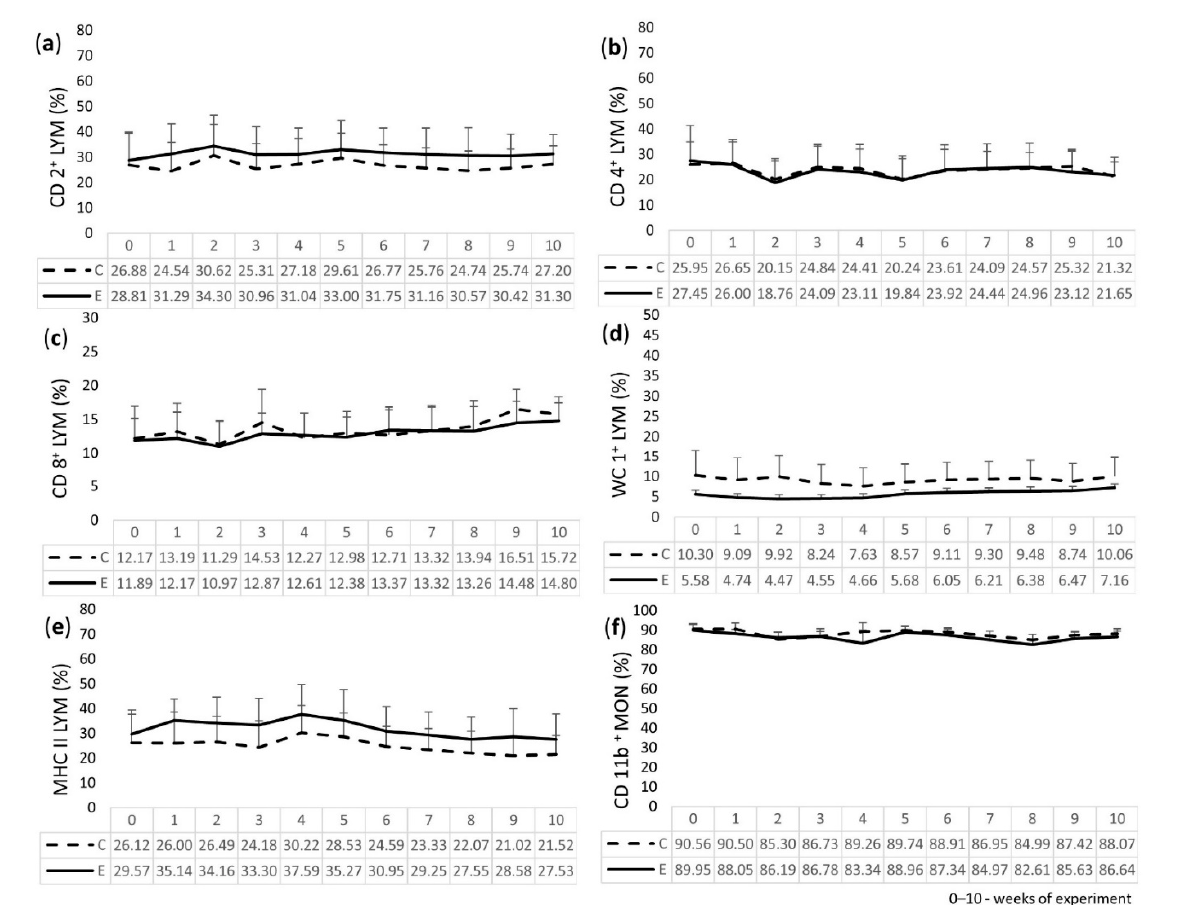
Figure 2. Percentage of the lymphocyte (LYM) subpopulations containing surface antigens in the peripheral blood of experimental (E) and control (C) calves: ( a ) CD2 + ; ( b ) CD4 + ; ( c ) CD8 + ; ( d ) WC1 + ; ( e ) MHC class II, and ( f ) percentage of the monocyte (MON) subpopulation containing CD11b + surface antigens.